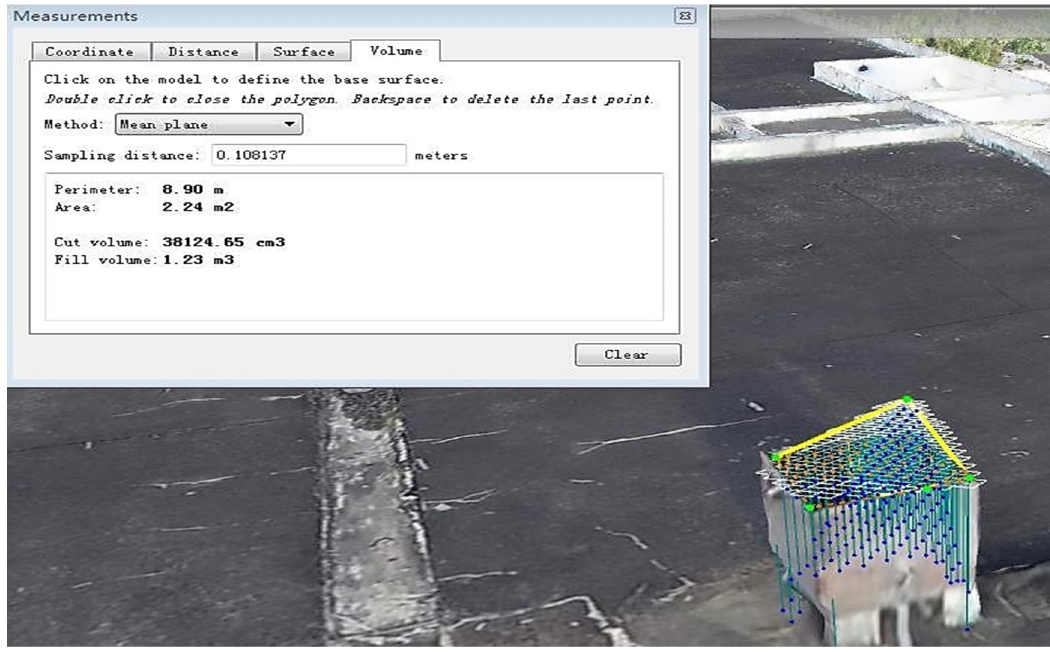
Figure 9. Application of volume measurement.